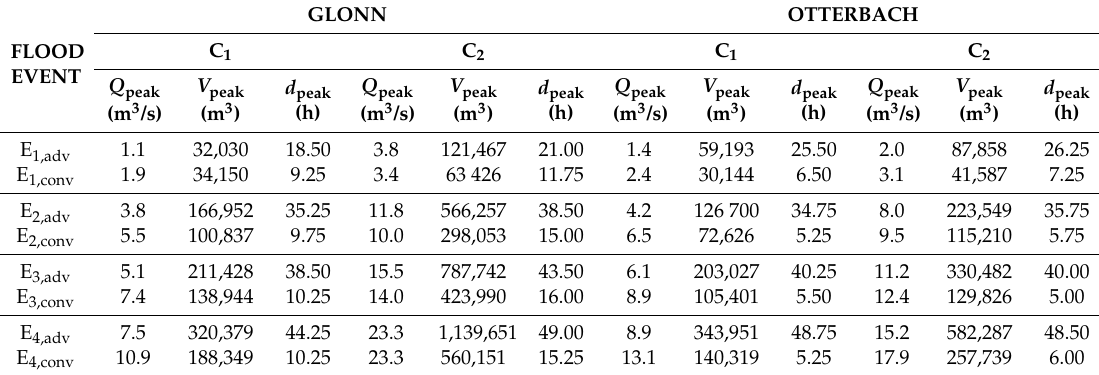
Table 4. Characteristics of the flood events at the cascade locations extracted from the HYDRO_AS-2D model of the current state. The duration ( d peak ) refers to the period between the beginning of the event and reaching the peak